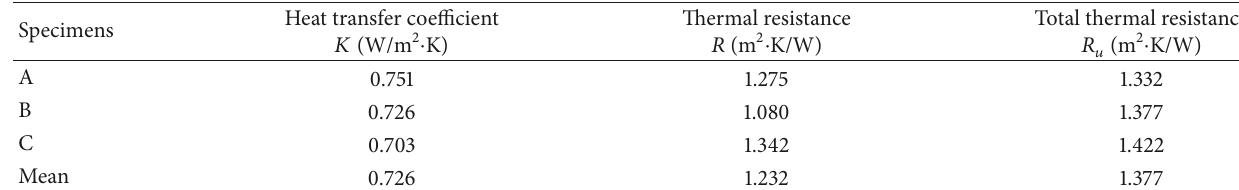
Table 2: Thermal parameters of the hollow shale block walls.